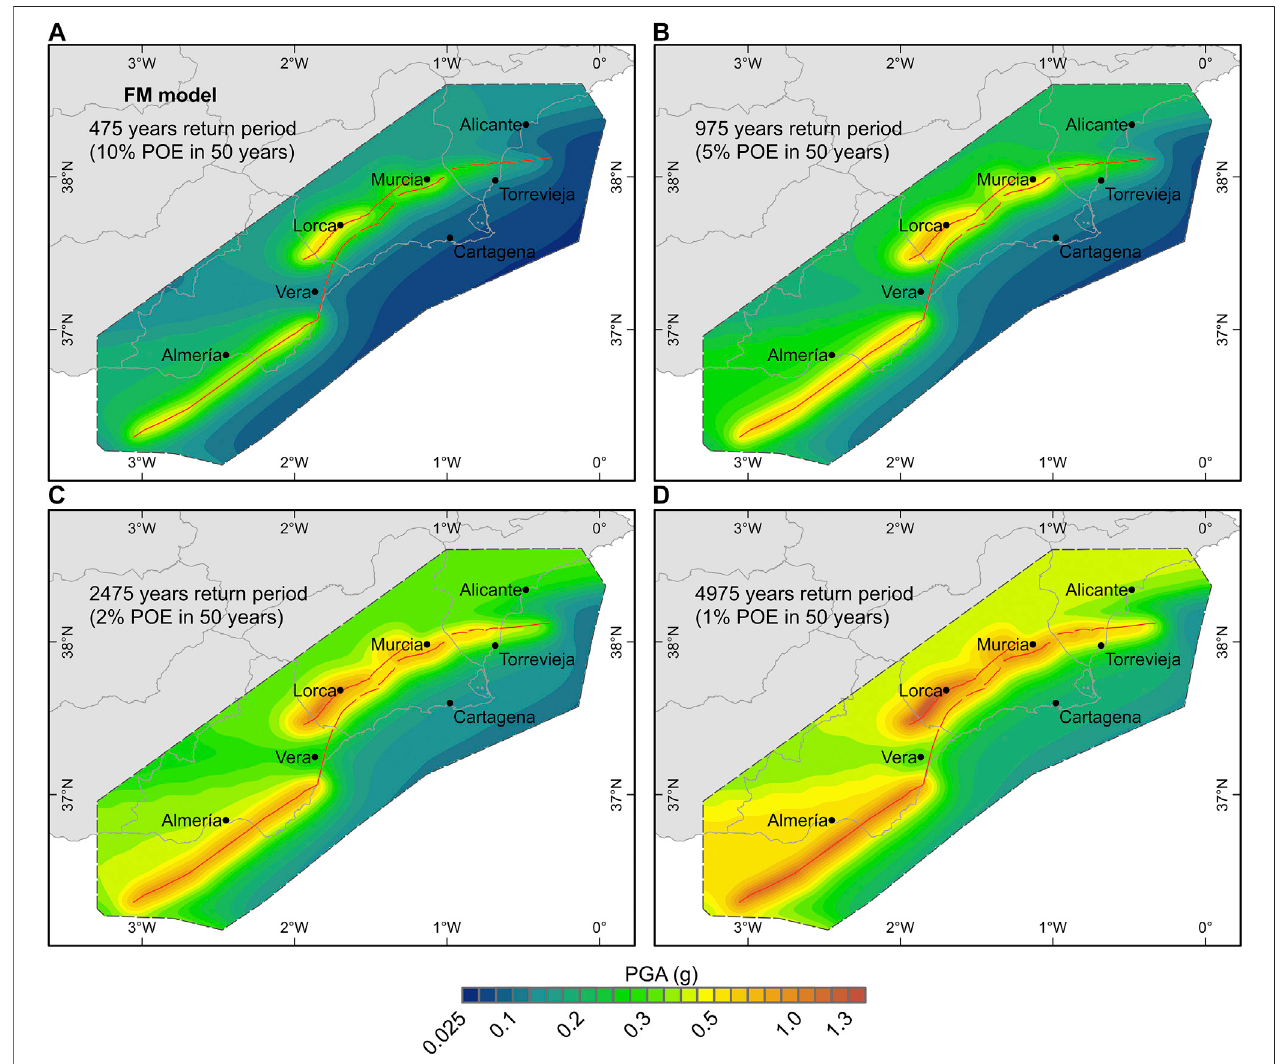
FIGURE 4 | (A) Mean hazard maps for PGA (g) of the FM model for the respective return periods (RPs) of 475 years; (B) 975 years; (C) 2,475 years and; (D) 4,975 years,equivalenttotheprobabilitiesofexceedance(POE)of10%,5%,2%,and1%,respectively.Acommoncolorscaleissetforallreturnperiods.Themaincities in the region and the traces of the EBSZ faults considered are depicted in red. See Figure 2A for the names of each fault.